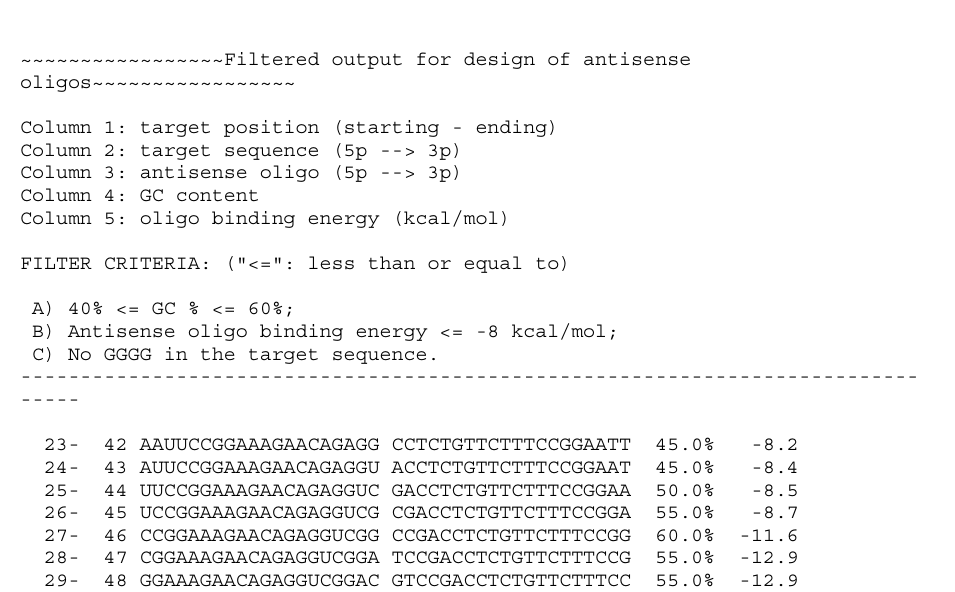
Figure 2. Fragment of example text Sfold output for CHS. Filtered oligos that meet designated criteria showed with their start—ending target position, energy and GC content parameters.